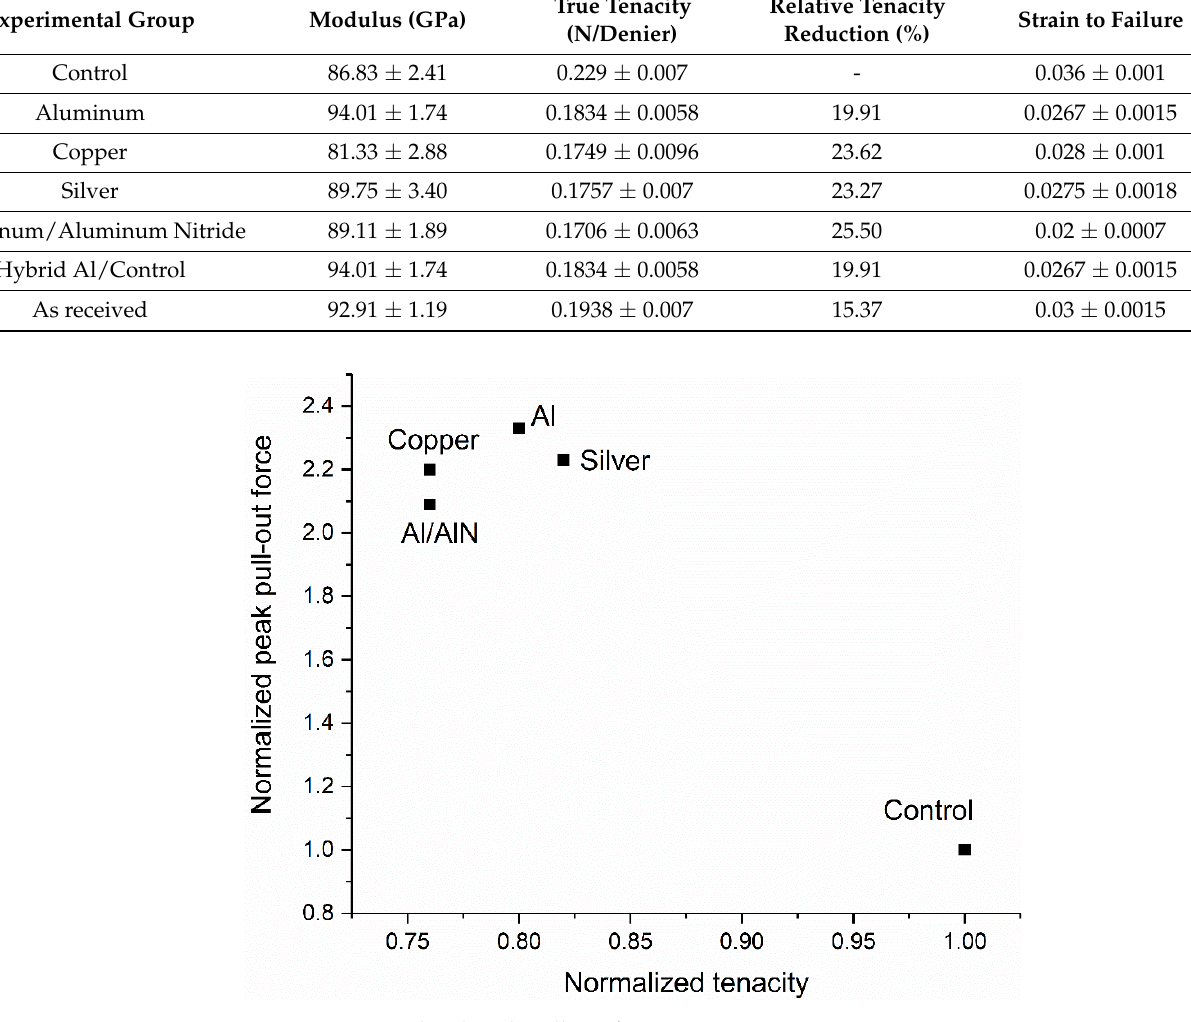
Figure 18. Normalized peak pull ‐ out force at 200 N transverse pre ‐ tension versus tenacity